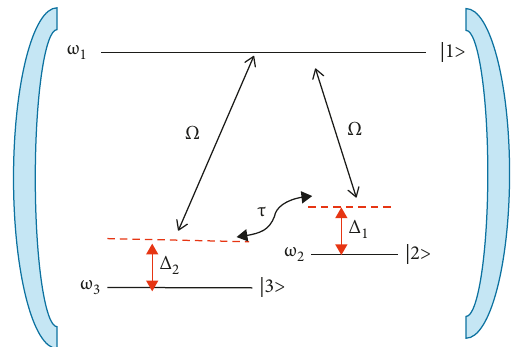
Figure 1: A sketch of the three-level atom in the located inside a cavity field with an external classical field. Here, ω 1 , ω 2 , and ω 3 are the frequencies of the levels, the quantized cavity field, and τ is the frequency of the external classical